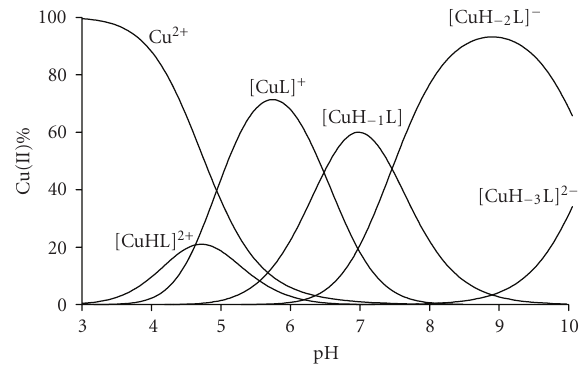
Figure 1: Metal ion speciation of the copper(II)-Ac-HHVGD-NH